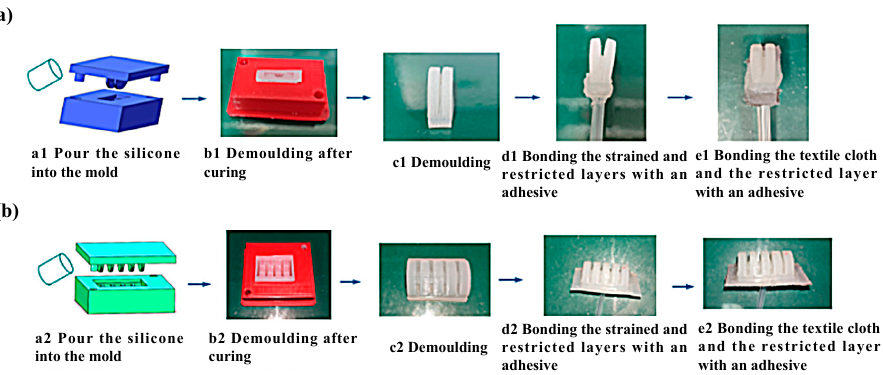
the surface of the limiting layer.